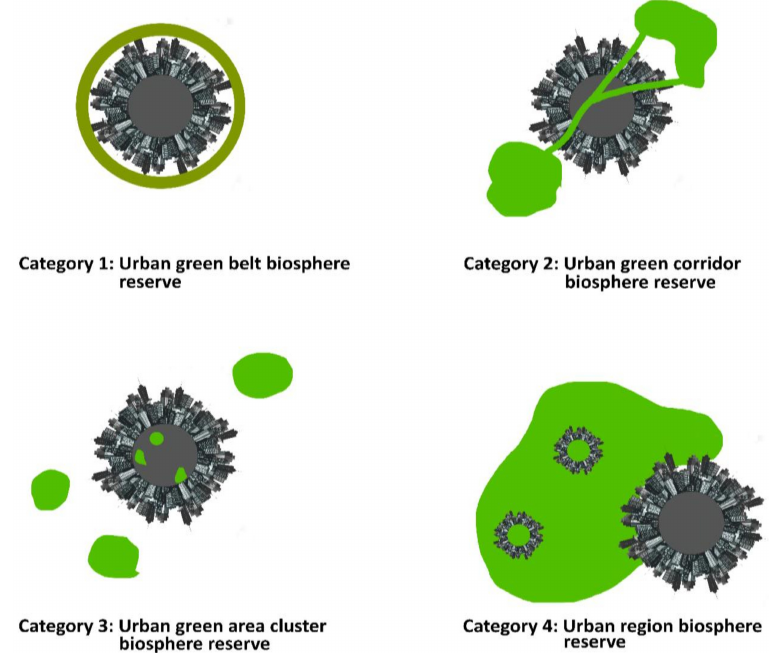
Figure 5. Types of biosphere reserves (Source: adapted from the 2018 UNESCO Man and Biosphere Programme, city image designed using